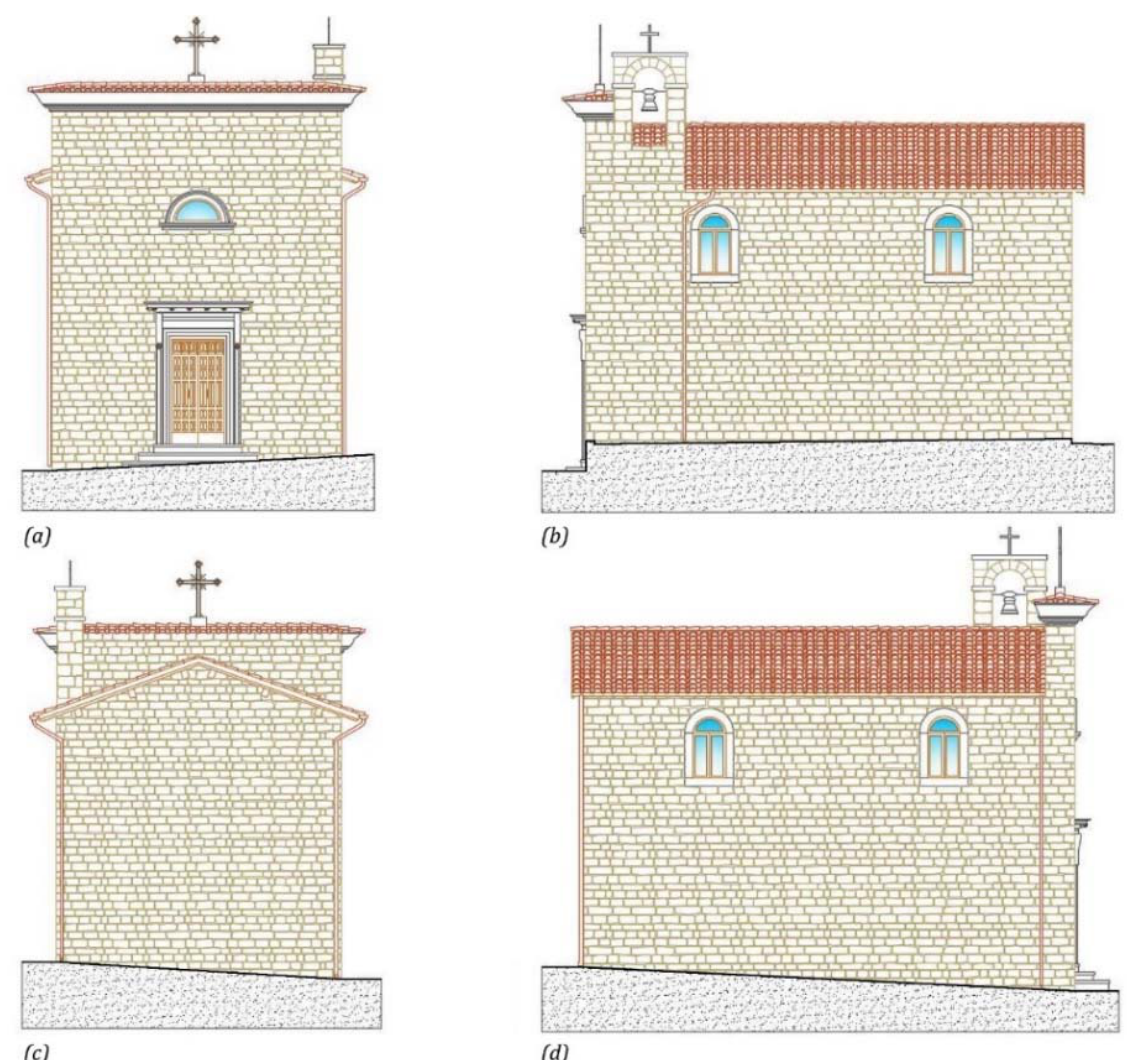
Figure 2. Geometric configuration (dimensions in meters) of the Santissimo Crocifisso Church in Pretare (Arquata del Tronto, AP): ( a ) plan at +1.00 m, ( b ) plan at +5.20 m, ( c ) section A-A, and ( d ) section B-B.